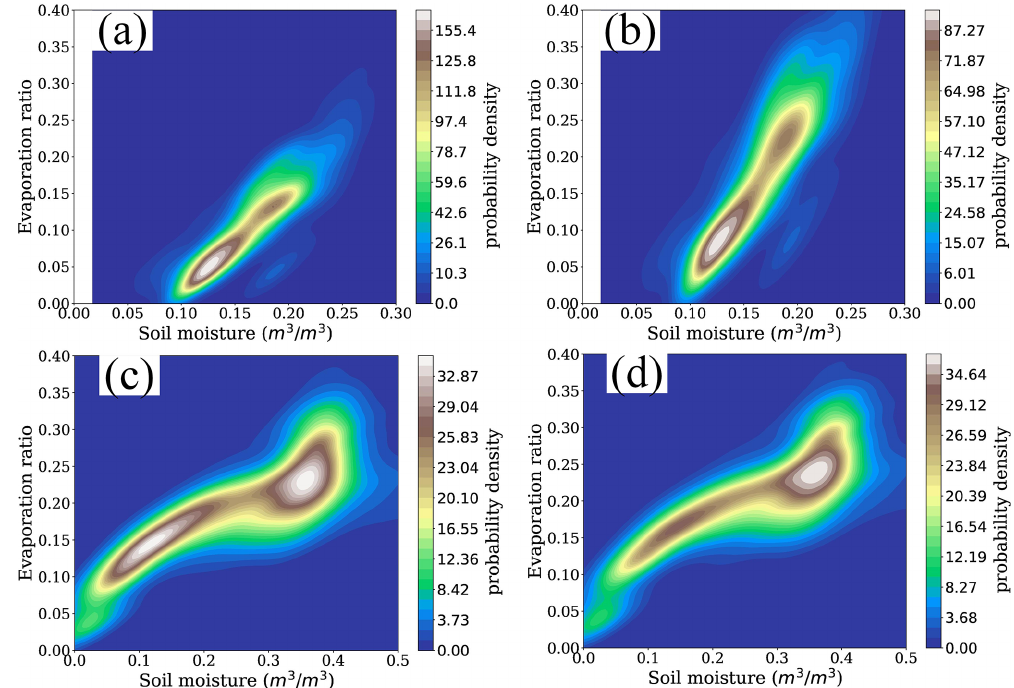
Figure 17. Probability distribution of the relationship between the evaporative ratio and the soil moisture in the stages before (a,c) and after (b,d) the middle to late 1990s for the TP based on GLDAS and ERA5.